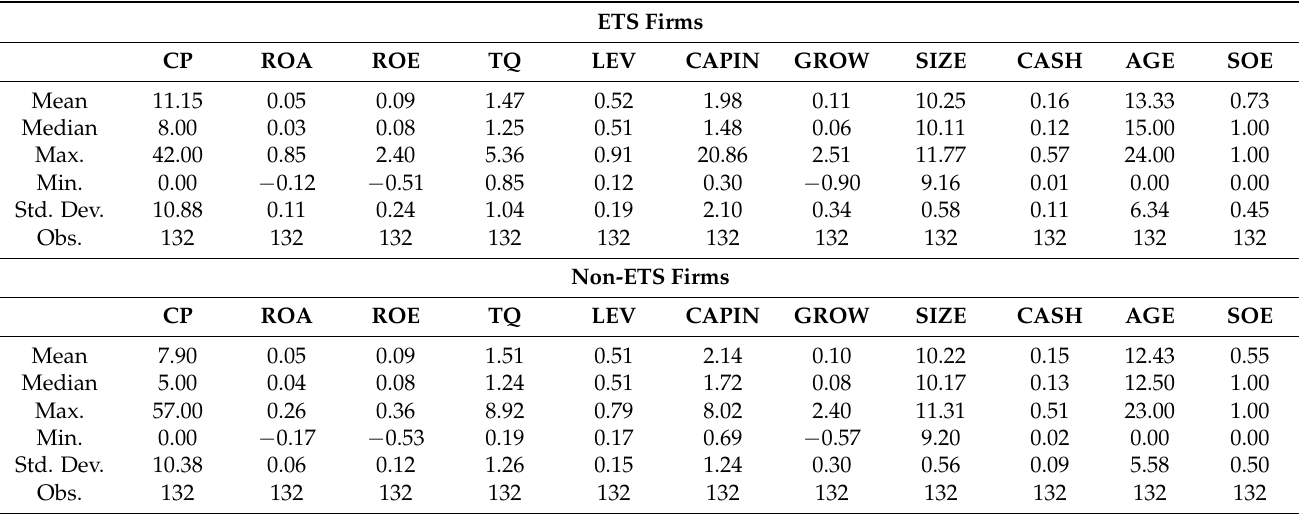
Table 5. Descriptive statistics: ETS Firms and Non-ETS